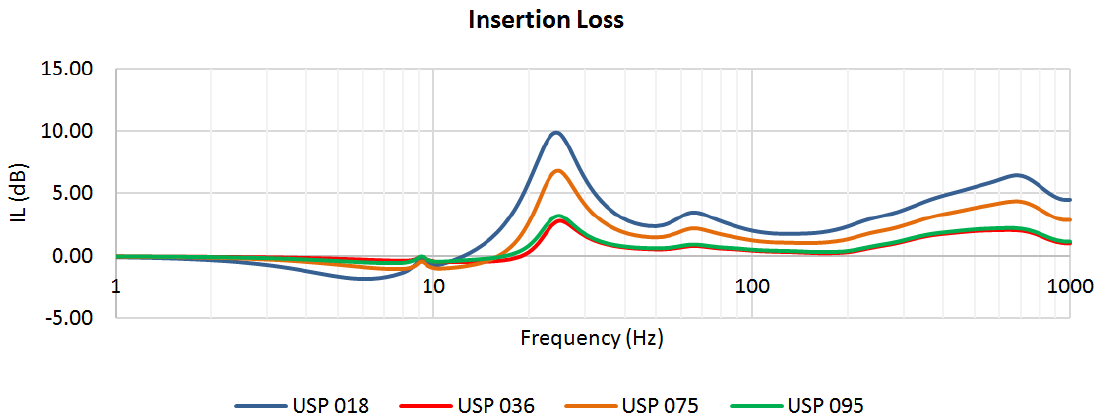
Figure 6. Insertion Loss: systems with four analyzed USP.